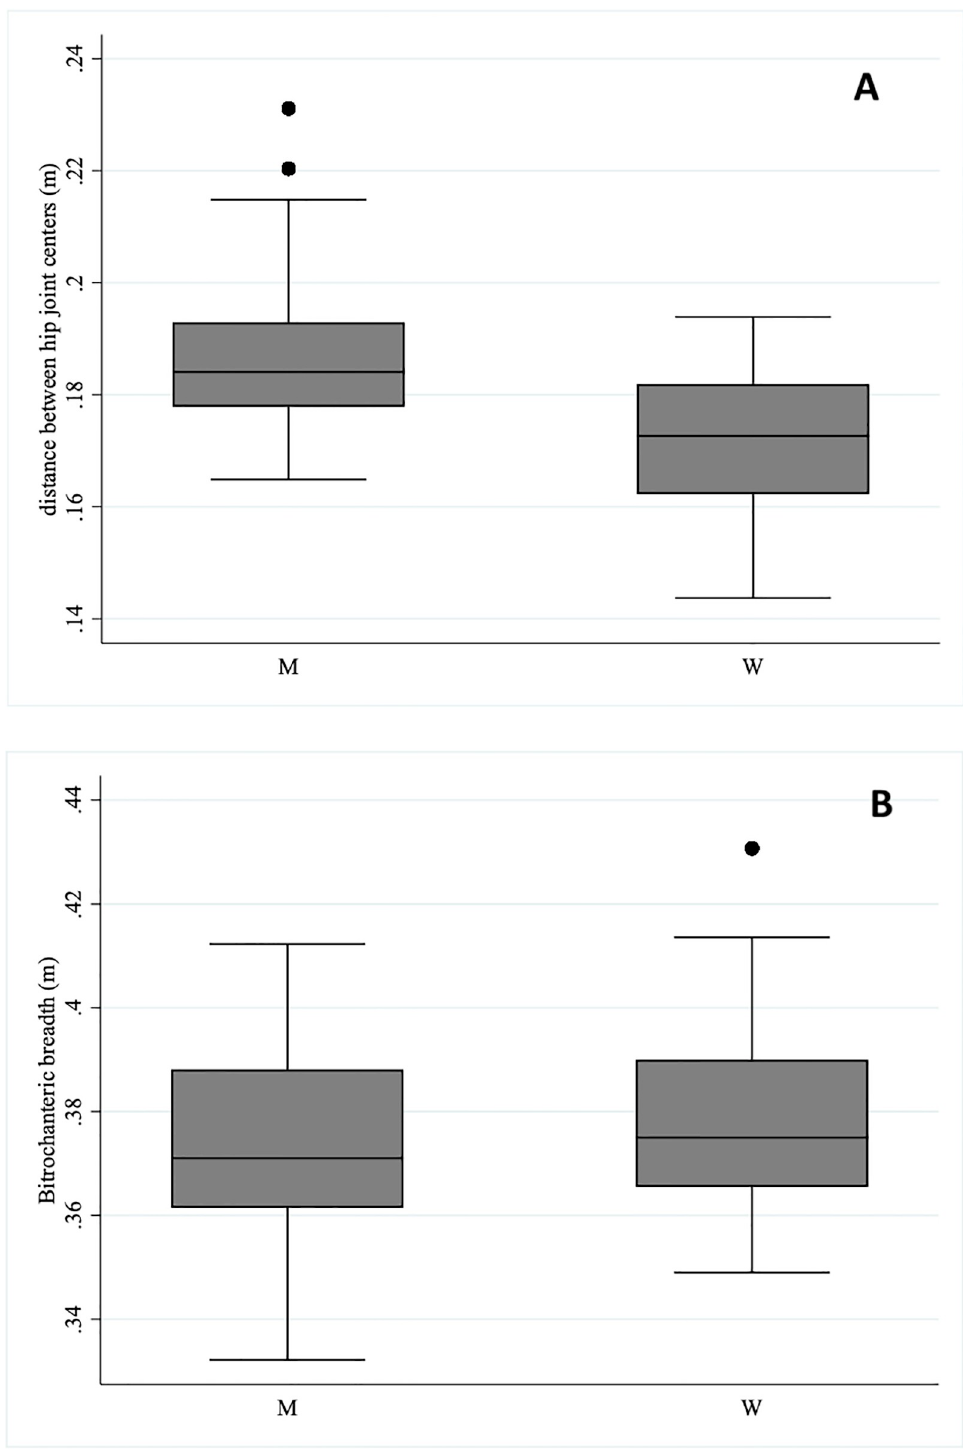
Fig 2. Functional distance between hip joint centers and bitrochanteric breadth in men (M) and women (W).